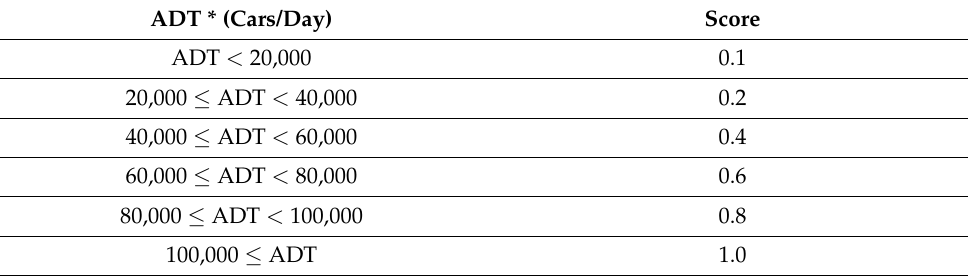
Table 4. Score by criticality factor.